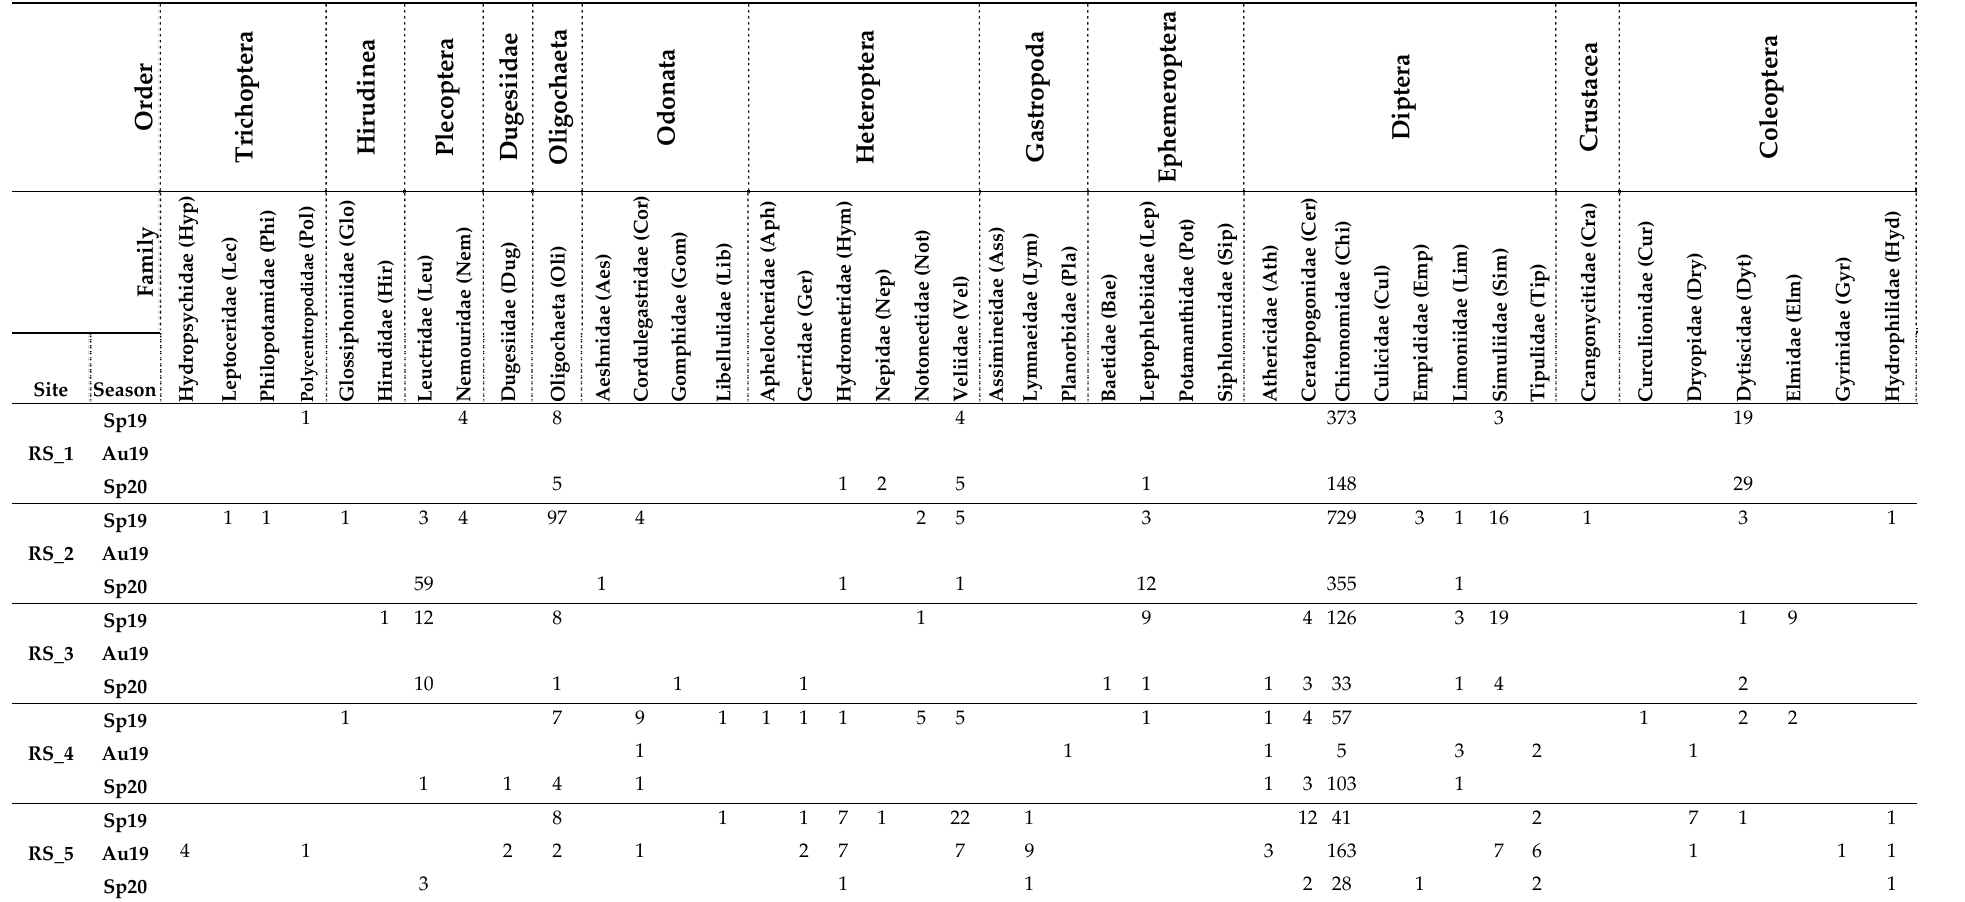
Table 2. Abundances of macroinvertebrates (number per sampling effort) at each site and a sampling period of Ribeira de Silveirinhos.